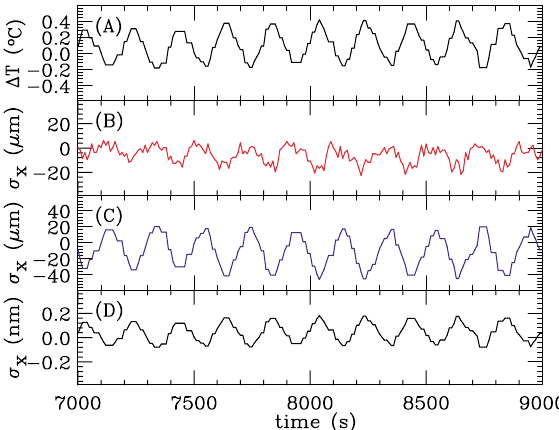
FIG. 5. (Color) (a) The average temperature variation of rf cavities. (b) The measured variation of the horizontal beam size. (c) The calculated variation of the horizontal beam size arising from the change of rf resonance frequency. (d) The calculated variation of the horizontal beam size due to the change of the higher-order parasitic loss factor.